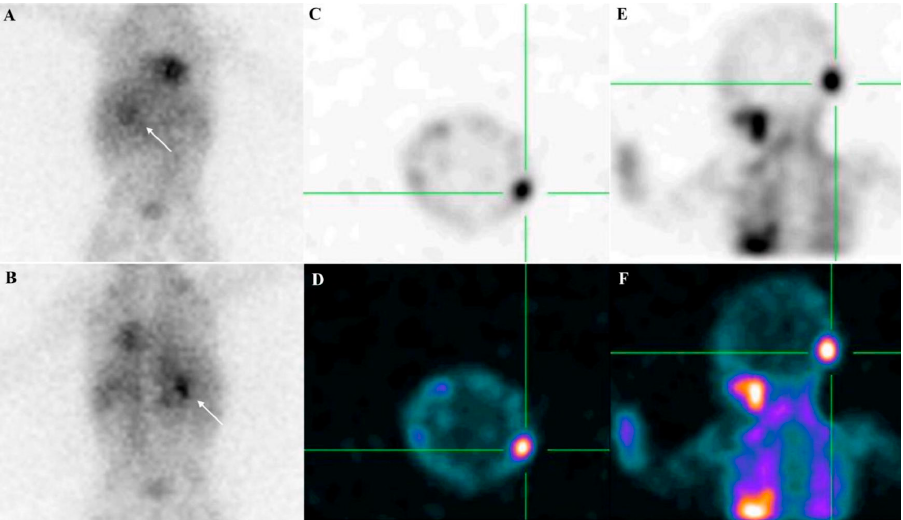
Figure 1. Pre-therapeutic staging in a 4-year-old child with neuroblastoma, performed with 123 I MIBG scintigraphy/ single-photon emission computed tomography (SPECT). Planar images ( A , anterior; B , posterior) show high uptake of the tracer in the right adrenal gland (white arrow), corresponding to the primary site of the tumor. Moreover, SPECT images of the skull ( C – F ) demonstrate the presence of metastasis in the occipital bone. Figures E and F display the physiological activities in the salivary glands and in the heart.